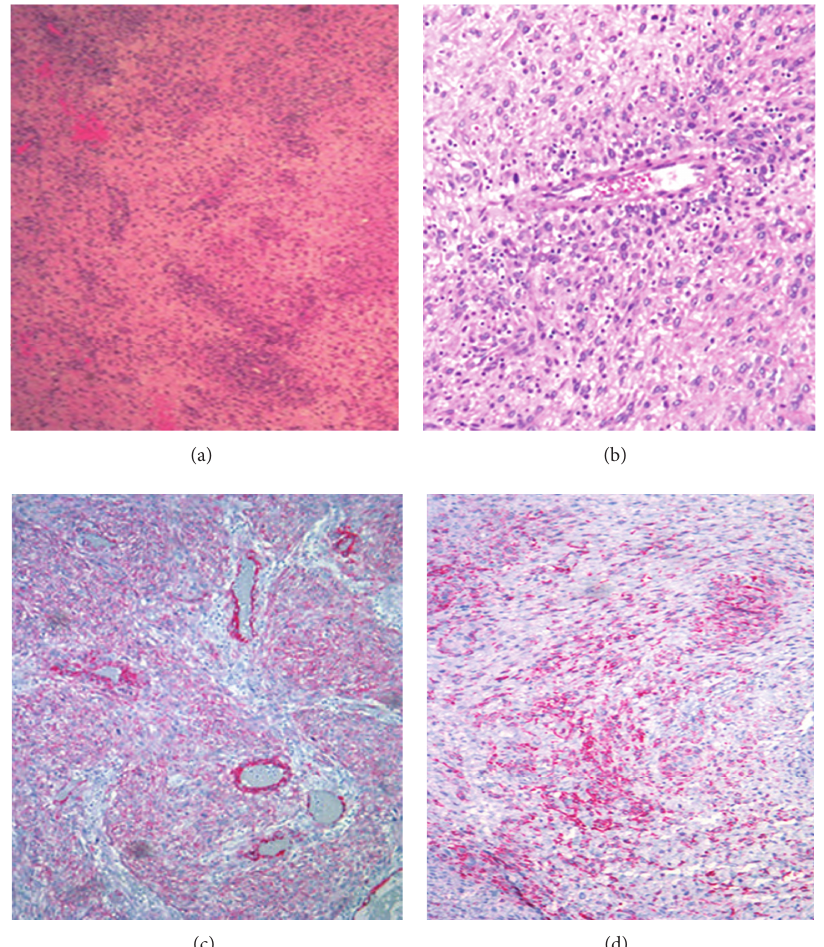
Figure 5: Perivascular condensation of tumor cells (H&E stain (a) × 2.5 and (b) × 20). Diffuse positivity for SMA ((c) × 10) and HMB-45 ((d) ×